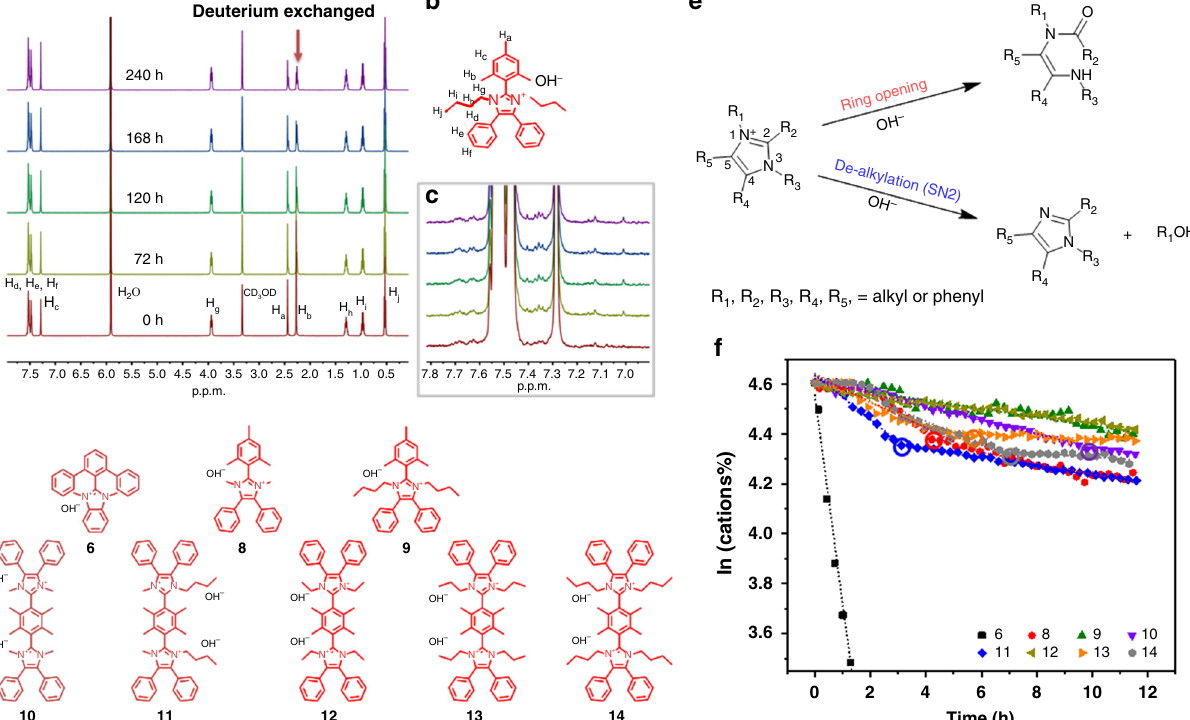
Fig. 2 Degradation of imidazolium. a , b , c Selected regions of the 1 H NMR spectra of 9 (0.02 M) in 3 M NaOD/CD 3 OD/D 2 O (7:3 wt. CD 3 OD:D 2 O) after being heated at 80 °C as a function of time. d , Compounds structure corresponding to plot in Fig. 2f. e , Degradation pathways of imidazolium cation. f Remaining percentage of model compounds 6 and 8 – 14 as a function of time at λ = 1 and 0.5 M OH − at room temperature. Circled points represent break points, see text for details. NMR-determined stability data of novel compound 9 – 14 are provided in Supplementary Figs. 1 –